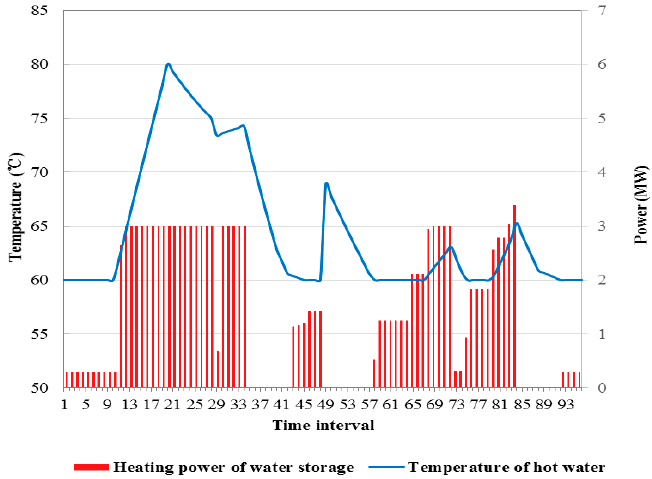
Figure 10. Heating power of the water storage tank and the temperature of hot water on a typical winter